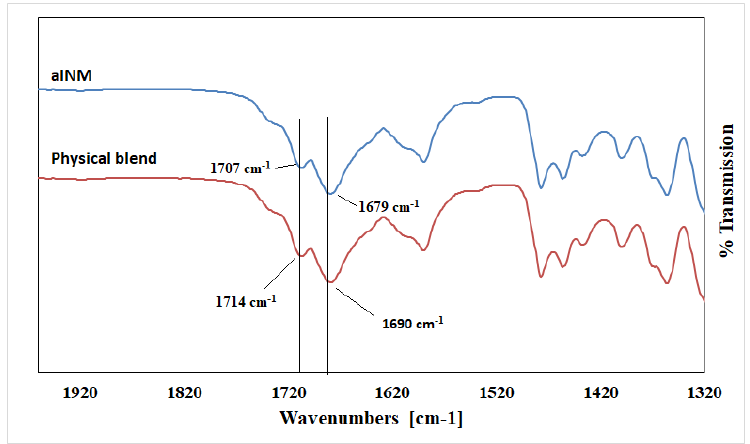
Figure 3. ATR-FTIR Spectra of aINM and Physical blend. Crystalline INM is still present in the physical blend as expected.